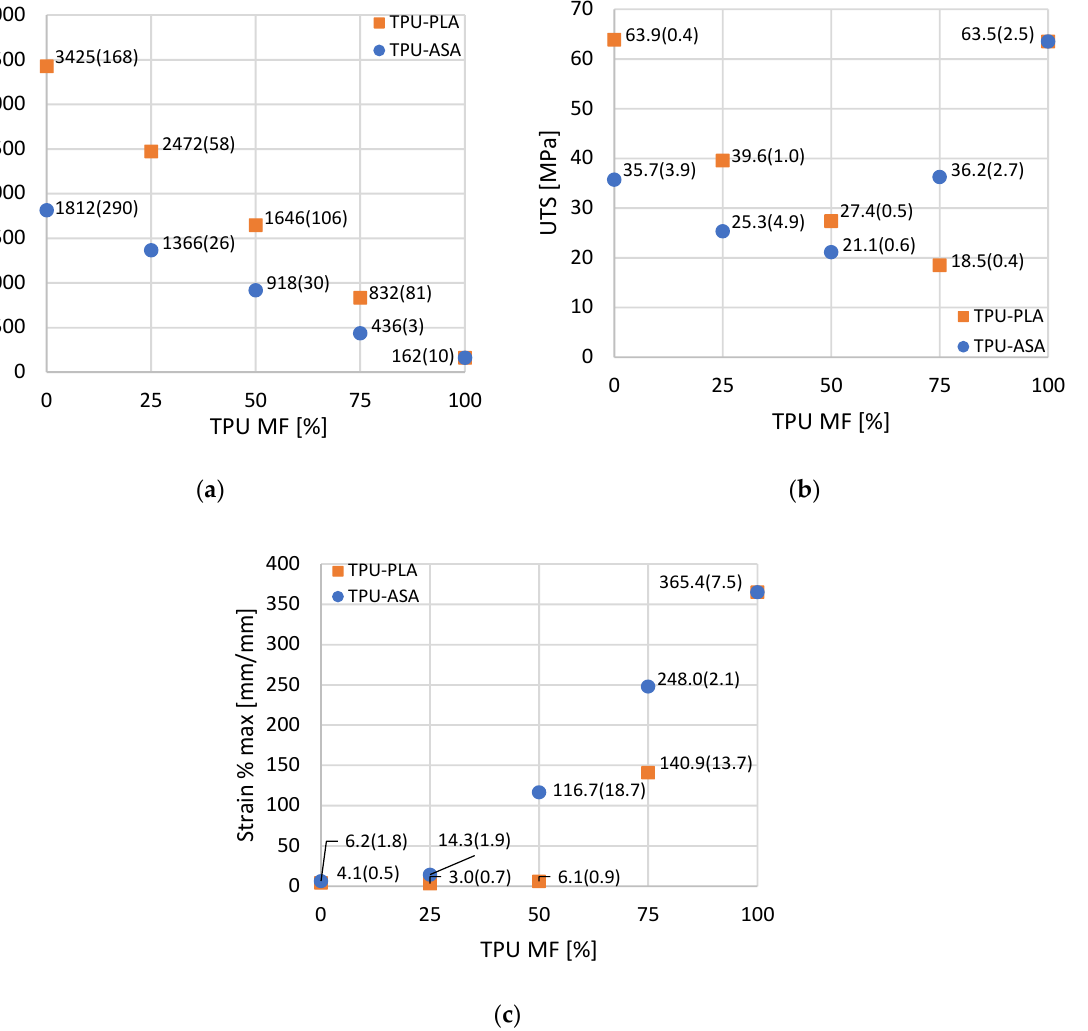
Figure 16. Results of the mechanical tests: ( a ) Young’s modulus, ( b ) Ultimate Tensile Strength, and ( c ) maximum strain.